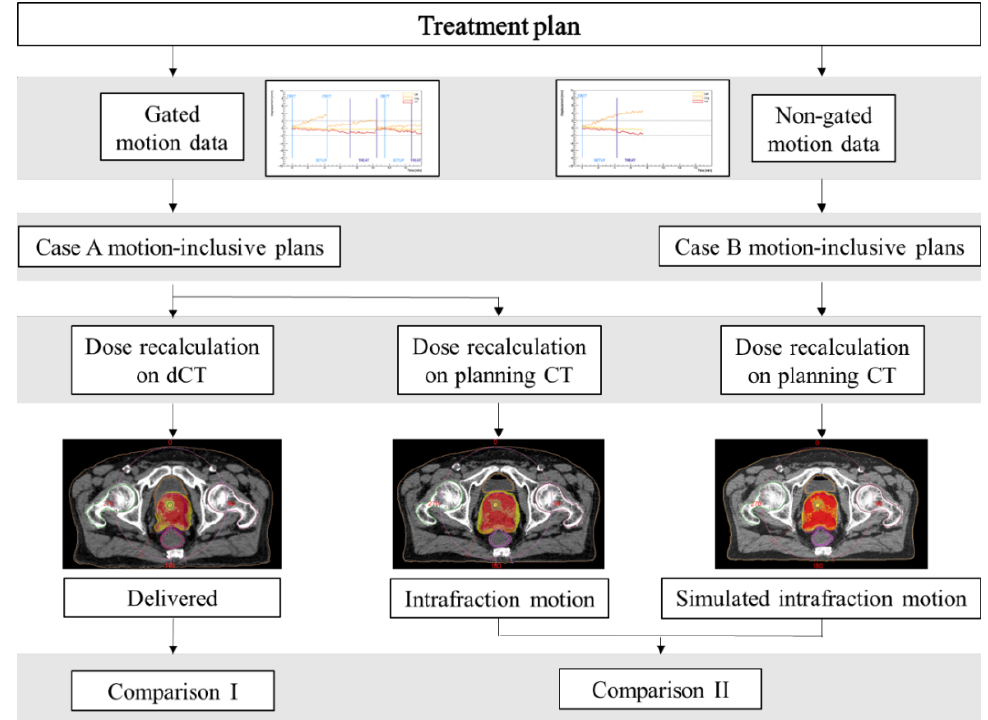
Figure 2. Overview of the data reconstruction process and dosimetric comparisons performed in the study.